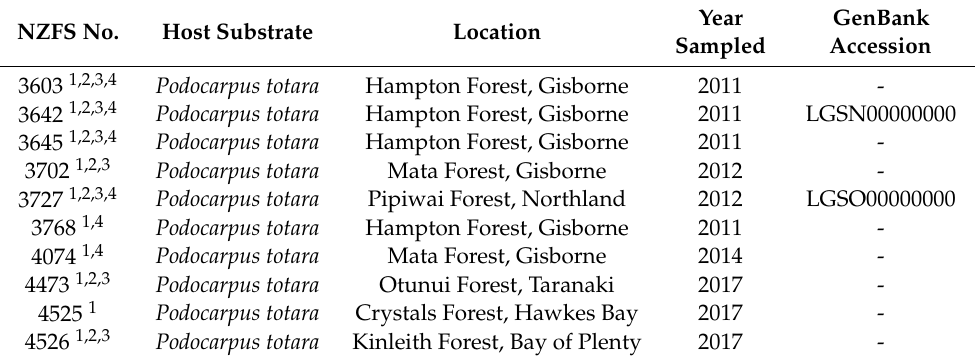
Table 1. Isolates used in this